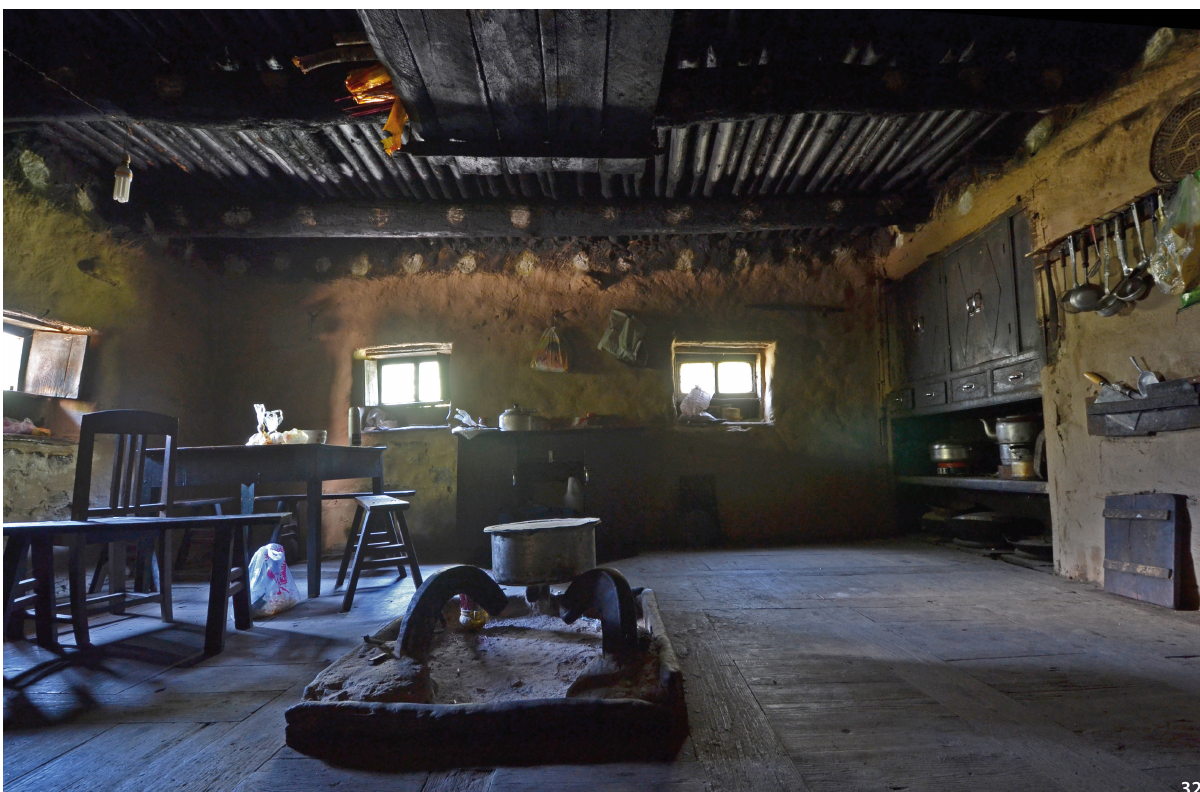
Figure 32 Interior of the fire place room on the first floor of the farmhouse in Gyalrong (Source: the authors).